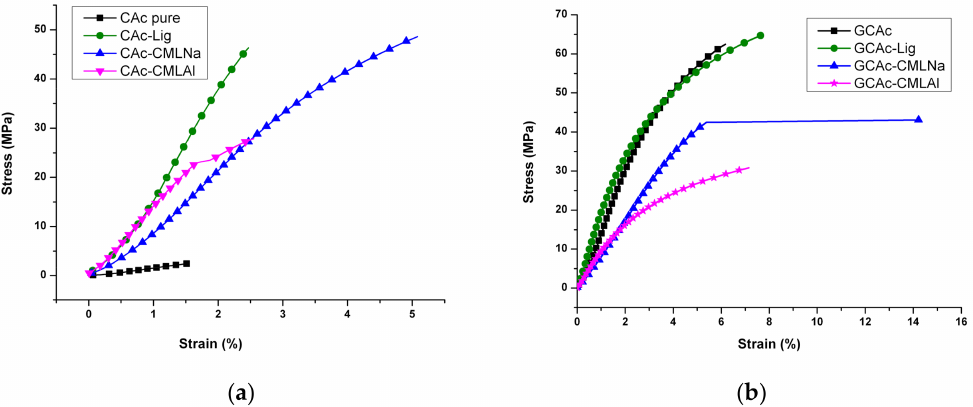
Figure 9. Stress-strain curves for the membranes of groups I ( a ) and II ( b ),